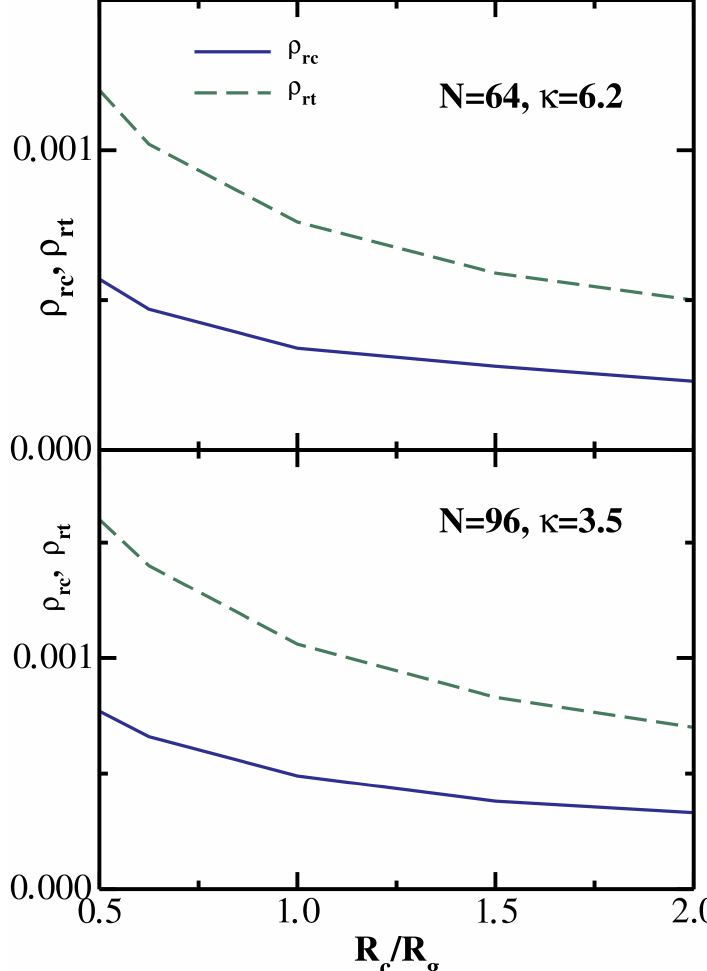
Figure 5. The monomer reservoir density corresponding to the liquid–vapor critical point ρ rc and to the vapor–liquid–solid triple point ρ rt as functions of the ratio R c / R g . Upper panel: semiflexible chain with ( N = 64, κ = 6.2); Lower panel: semiflexible chain with ( N = 96, κ =